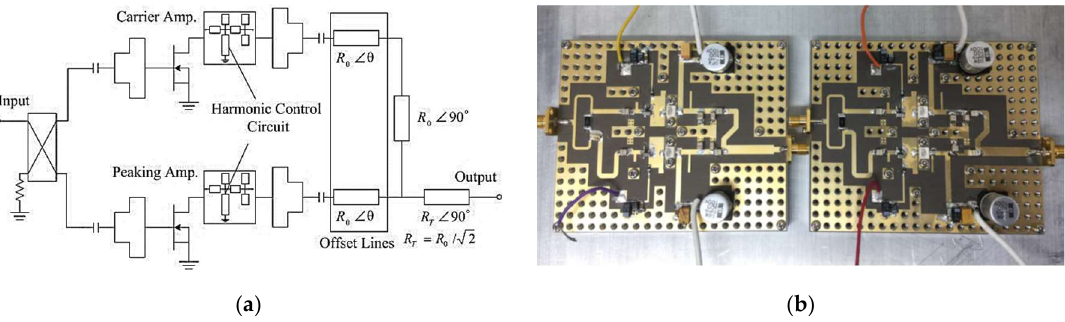
Figure 6. ( a ) Schematic of Class-F based DPA [49], ( b ) Realized Class F −1 /F −1 left, and Class F −1 /F right DPA in [50].